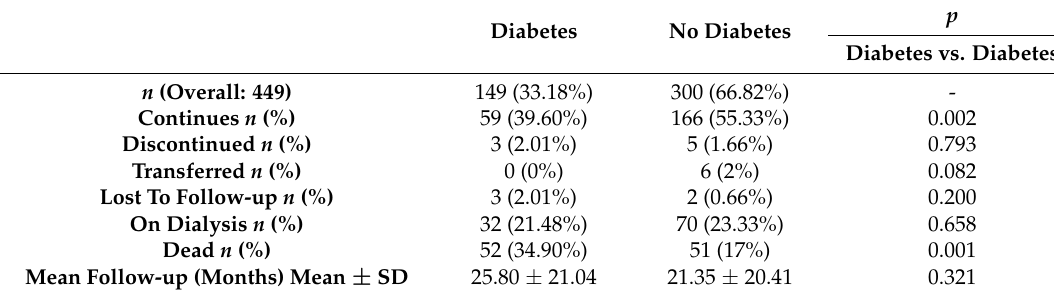
Table 8. Table on line only. Main outcomes: Distribution according to the presence, absence of